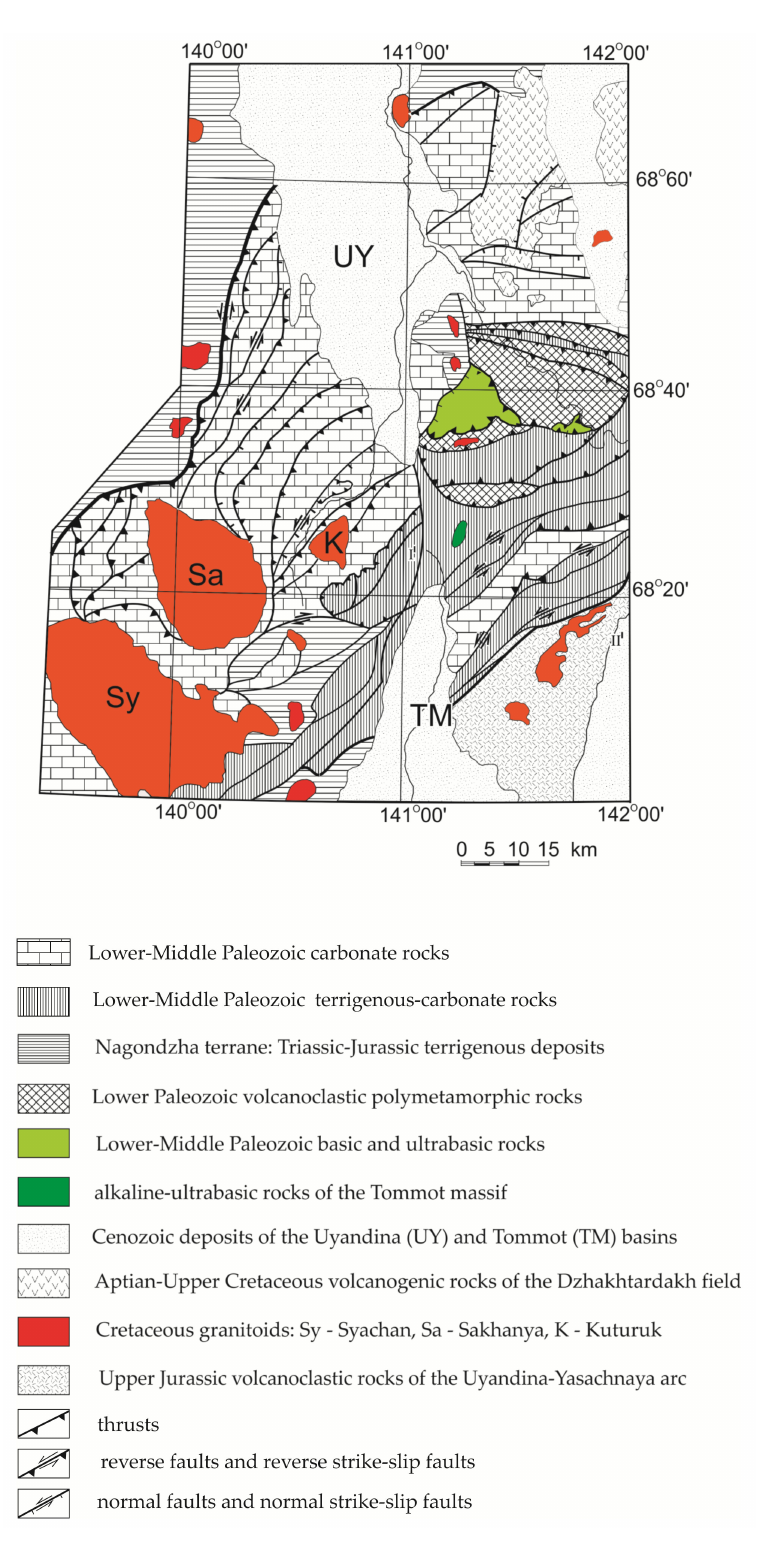
Figure 2. Structure of the Selennyakh block of the Omulevka terrane